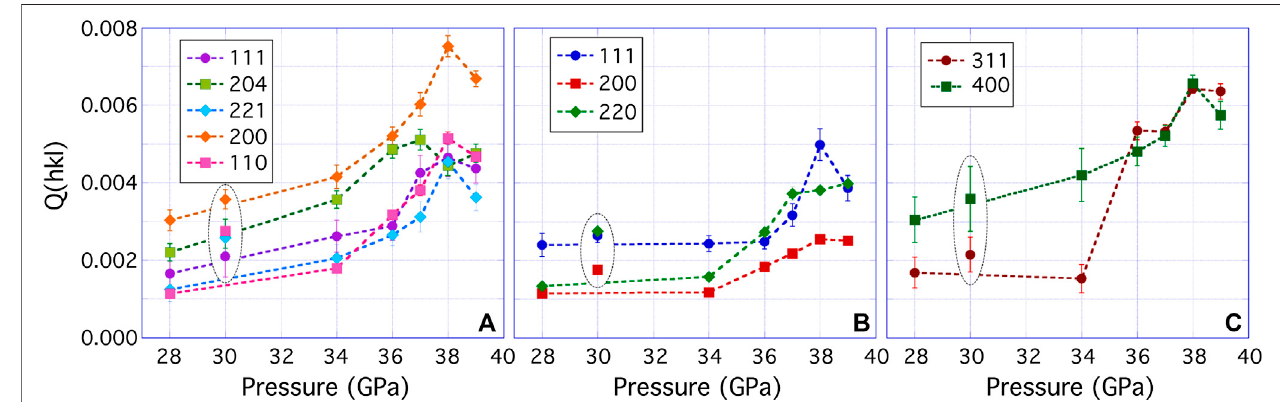
FIGURE 4 | Variation with pressure of experimental Q ( hkl ) values of the individual phases (A) bridgmanite (B) ferropericlase, and (C) ringwoodite present in the aggregate compressed non-hydrostatically at ∼ 1,000 K. Additional values of Q ( hkl ) of the converted assemblage at 30 GPa and 300 K (image 001) are shown inside black,dashed elliptic contours for reference. Pressures are based on the unit cell parameter ofPt ( Table 1 ). Experimental values for Q ( hkl ),based on latticestrain theory (Singh et al., 1998) were determined as part of the Rietveld re fi nement procedure performed with Materials Analysis Using Diffraction software. Bars showing standard deviations from the software are given on each data point and dashed lines are a guide for the